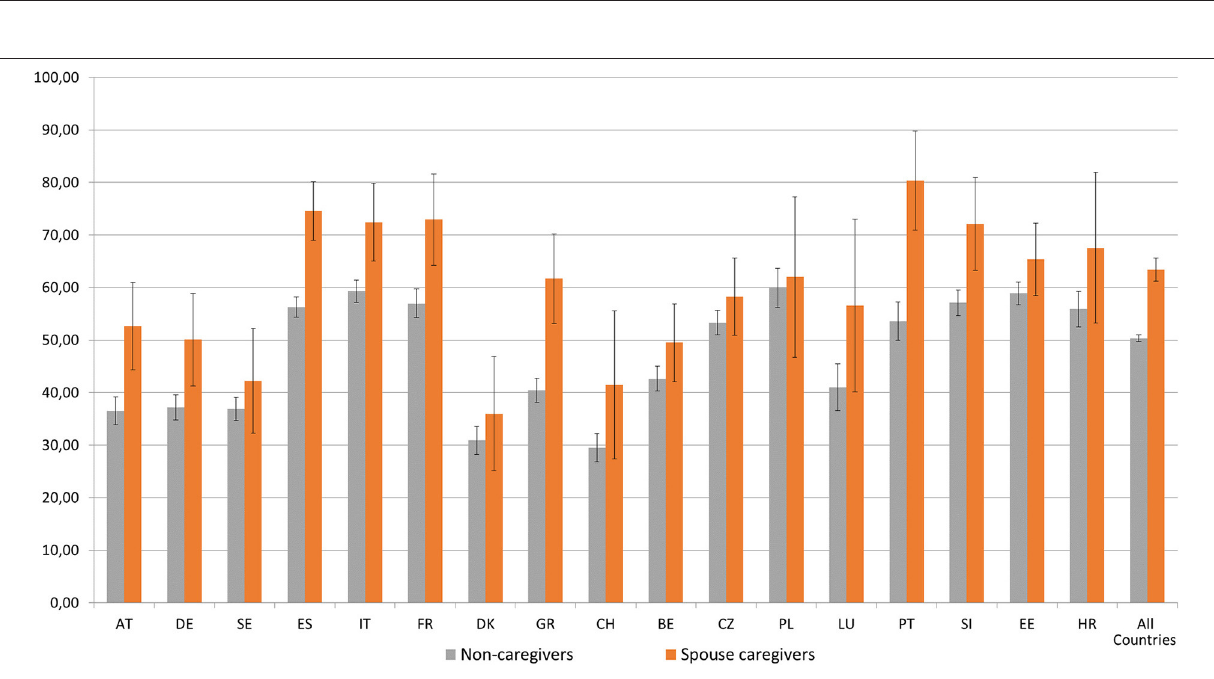
Odds ratios (OR), 95% confidence intervals (IC), p -value ( p ), intra-class correlation coefficient (ICCcountry), between- country variance, and deviance of the statistical model are